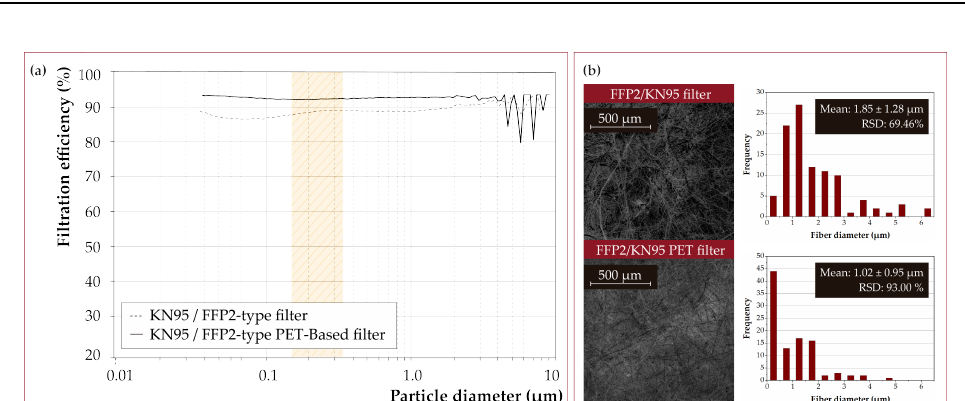
Figure 11. ( a ) Filtration efficiency of a PET-based FFP2/KN95-type filter prepared in this work compared to a commercial filter mask. The polydispersity range of particles used in the EN 149:2001 standard, applicable to FFP2 (similar to KN95) and FFP3 (similar to KN99) masks, is marked in yellow. ( b ) SEM micrographs and fiber size distribution histogram of electrospun and commercial fibers ( n =